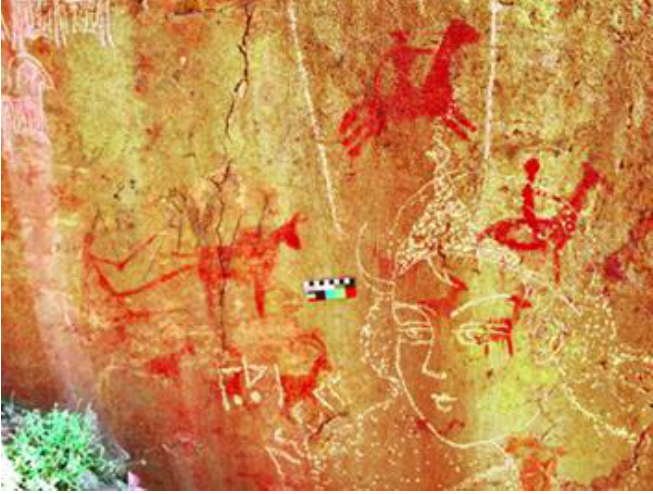
Figure 19. Site V. A panel consisting of ploughing depiction, horse riders and ibexes (enhanced using Dstretch).